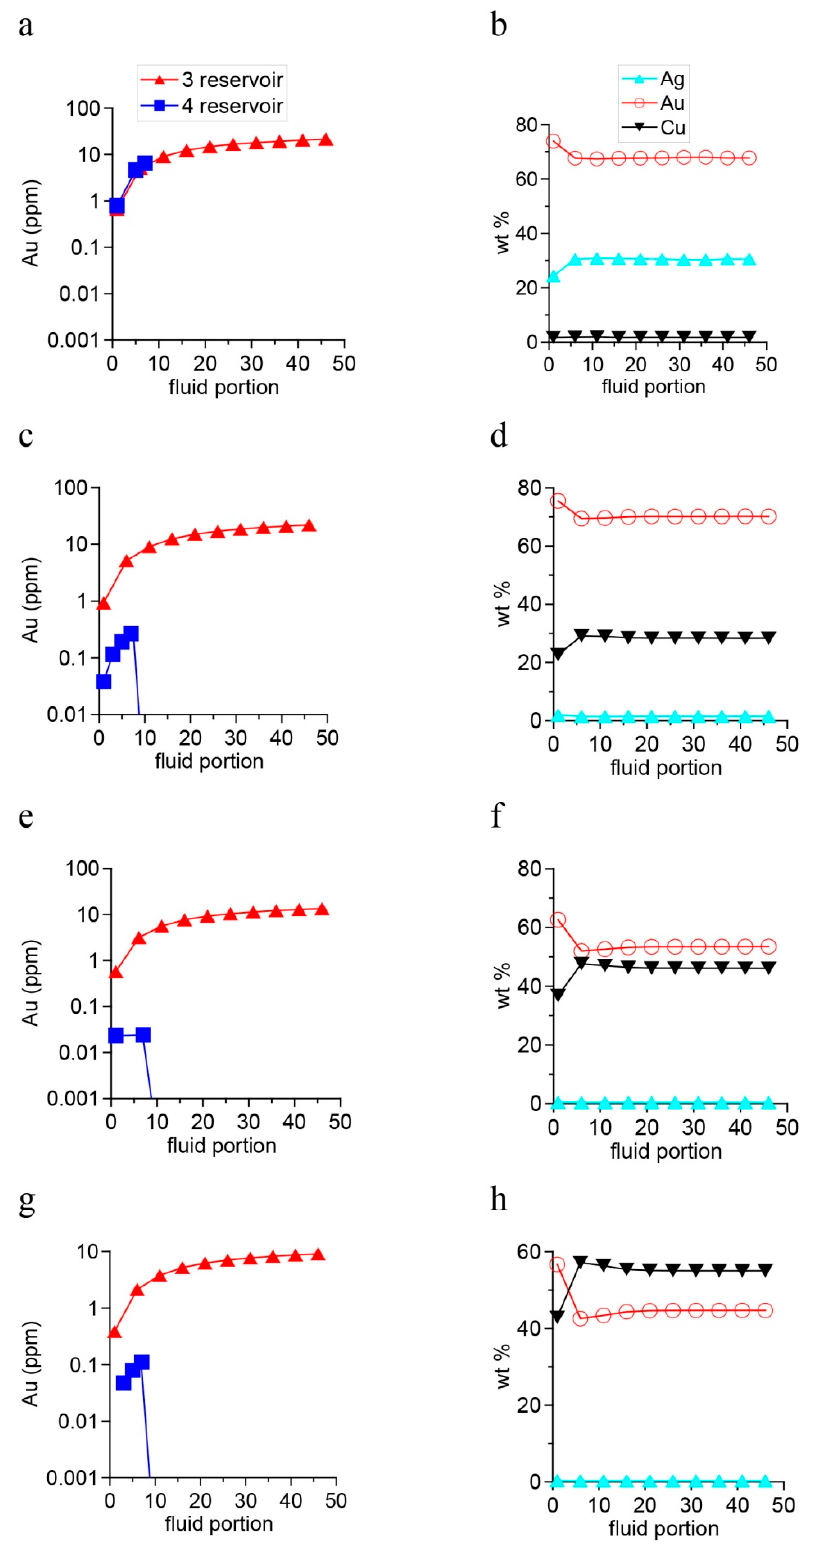
Figure 8. Distribution of gold in the model at the ratios of Au, Ag, Cu, and Hg in the fluid according to their average concentrations in ultramafic (U) and mafic (M) rocks (Table 1), specified in different proportions: ( a , b ) U, ( c , d ) 0.75 U and 0.25 M, ( e , f ) 0.25 U and 0.75 M, and ( g , h ) M. ( a , c , e , g ) Au in rock (third and fourth reservoirs); ( b , d , f , h ) components in Ag-Au-Cu solid solution (third reservoir).